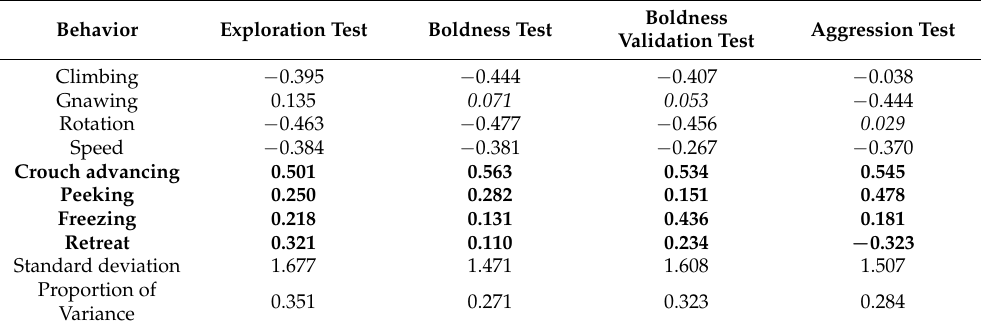
Boldness Aggression Test Validation Test